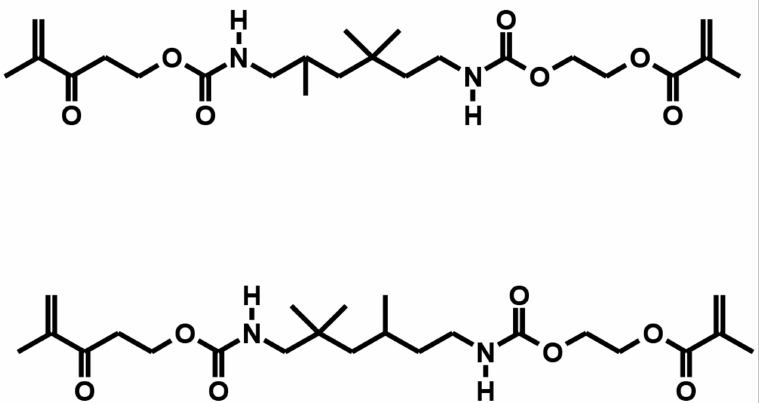
Figure 5. Structural formula of urethane dimethacrylate (the main component of BioM1).